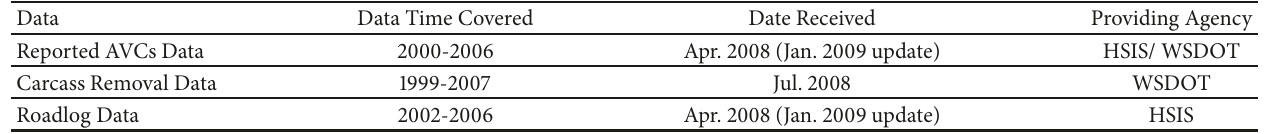
Table 1: Data collection information.